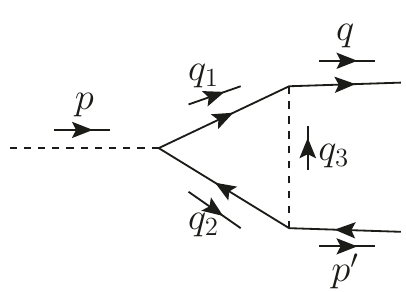
Figure 13 . Particle directions and momenta of the vertex diagram as shown in figure